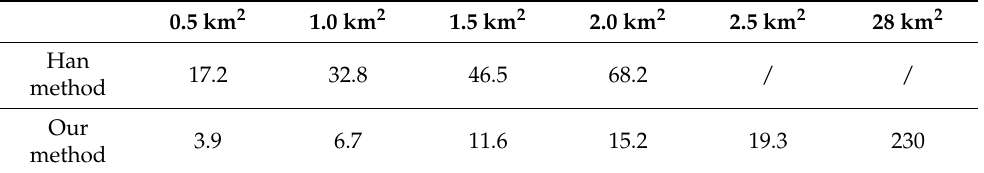
Table 6. Comparison of the time consumed using the two methods for hole filling in different experimental